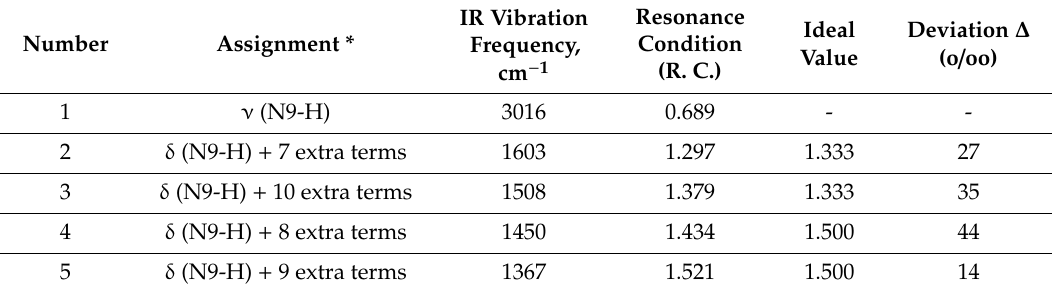
Table 7. Series of FTIR data on anhydrous adenine, numbers 1–5, from an investigation with detailed analysis of the spectral assignments. The “resonance condition” is calculated as was done in Table